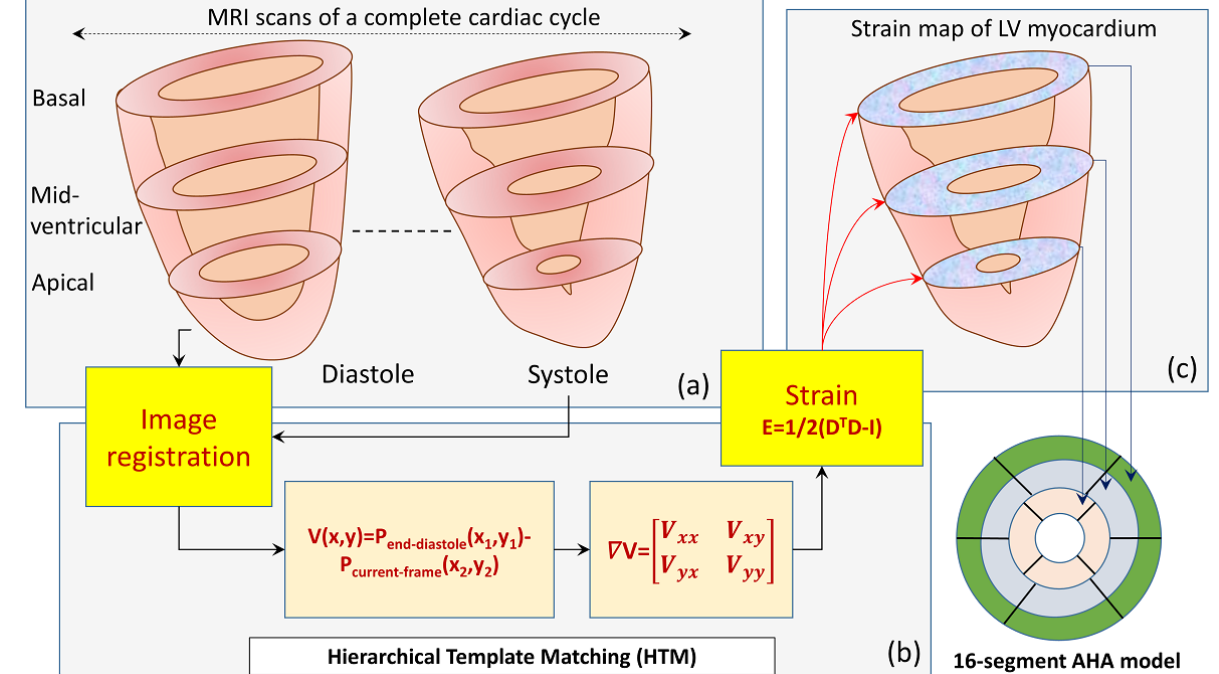
Figure 2. (a) MRI scans of a cardiac cycle at three LV levels: Basal, Mid-ventricular, and Apical. (b) HTM method to calculate strain values at each muscle point. V is mentioned in (Equation 2). (c) LV strain values, which are analyzed using the 16-segment AHA model. AHA: American heart association; HTM: hierarchical template matching; LV: left